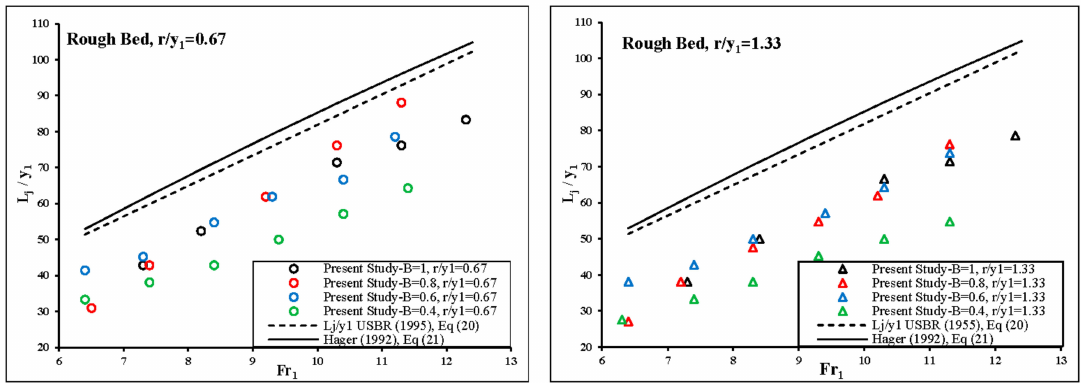
Figure 13. Variation of the relative length of the hydraulic jump (L j / y 1 ) vs. the inflow Froude number with different divergence ratio on a rough bed.